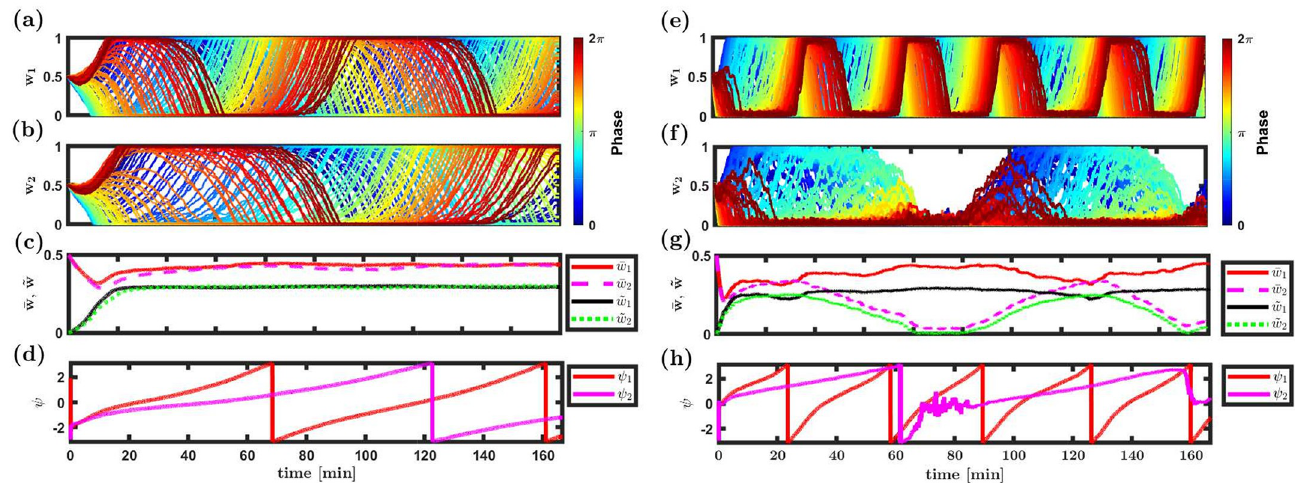
Fig 8. STDP dynamics with a conductance based downstream neuron. Results of two numerical simulation of STDP dynamics with a conductance based downstream neuron are presented: ( a )-( d )using a downstream neuron with a linear f-I curve, and ( e )-( h ) using a downstream neuron with a non-linear f-I curve, see Details of numerical simulations in Methods. (a), (b), (e) and (f) The synaptic weights are shown as a function of time for population 1 (in a and e) and population 2 (in b and f). The different traces show the dynamics of different synapses colored by the preferred phase of their pre-synaptic neuron, see legend. (c) and (g) The dynamics of the order parameters: the mean, � w , and first Fourier component, ~ w , are shown as a function of time for both populations, see legend. (d) and (h) The dynamics of the phases, ψ 1 and ψ 2 , is shown as a function of time in red and pink, respectively. Here we used the temporally asymmetric STDP rule, Eq (11). Additional parameters are: N 1 = N 2 = 120, � n � n = ð 2 p Þ ¼ 11 Hz , � n ¼ 14 Hz , α = 1.1 and μ = 0.011. The learning rate λ in the non-linear case is 5 times larger 1 1 2 than in the linear case. For further details see Methods.